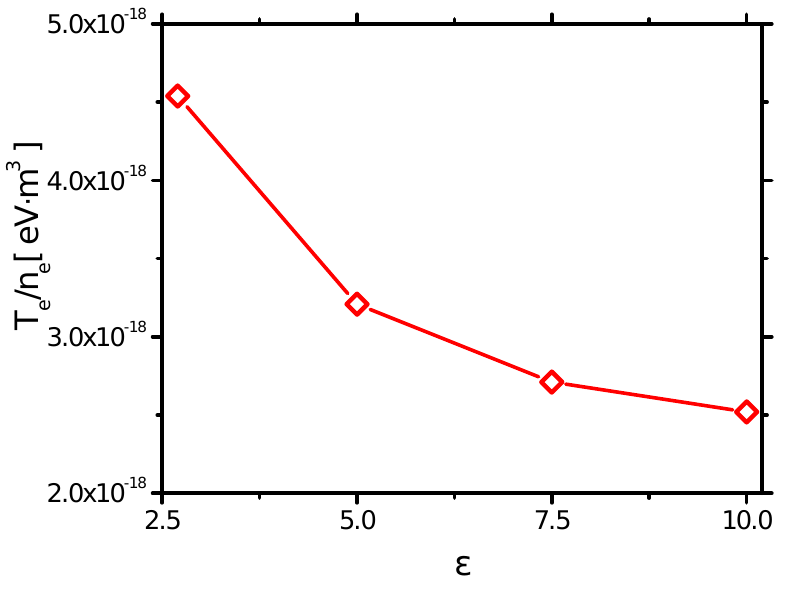
Figure 17. The effects of ε on T e